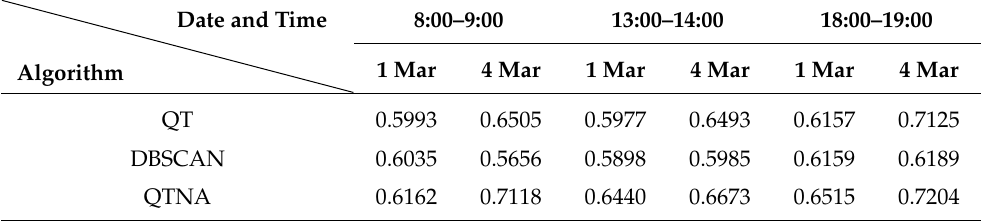
Table 1. Performance comparison of clustering algorithms based on pick-up locations during the same time period on different dates.